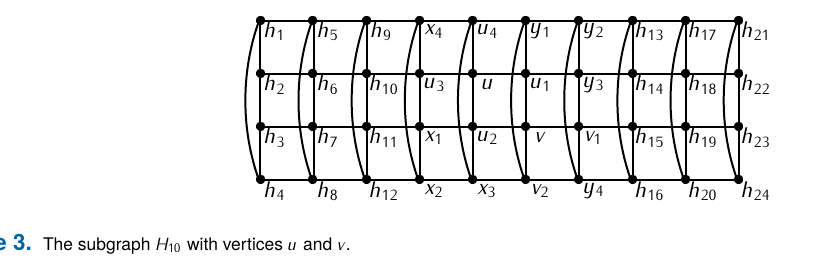
with vertices u and v 10